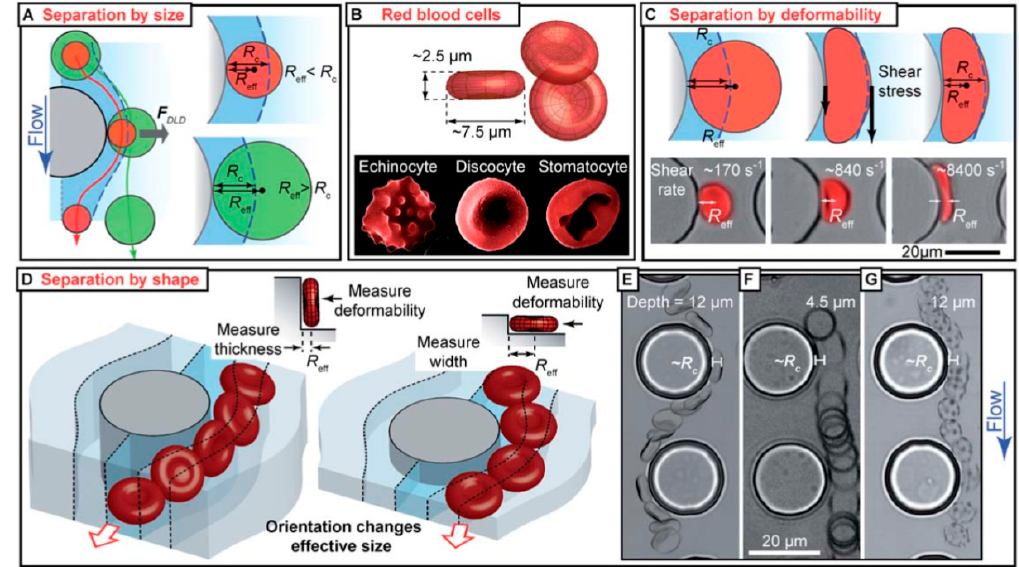
Figure 17. Mechanisms of separation by DLD with respect to cell size, shape, and deformability as in the case of RBCs. ( A ) The principle of DLD separation: particles with R e ff < R c follow the flow direction and those with R e ff > R c are displaced at an angle to the flow direction. For hard spheres, R e ff is equal to the radius. ( B ) Red blood cells are normally disc–shaped but they can adopt other shapes when exposed to di ff erent chemicals. ( C ) Shear forces deform particles changing R e ff , and measuring the change in R e ff as a function of applied shear rate is equivalent to measuring the deformability of the particle. ( D ) R e ff depends on the orientation of the particle. Controlling orientation and measuring R e ff gives information about shape. It is also possible to measure deformability in di ff erent directions. ( E ) In a deep device RBCs rotate such that R e ff ( < R c ) is equal to half the thickness. ( F ) Confinement in a shallow device means that the cell radius defines R e ff ( > R c ). ( G ) An echinocyte with R e ff > R c . Reprinted with permission from [329]. Copyright 2012, the Royal Society of